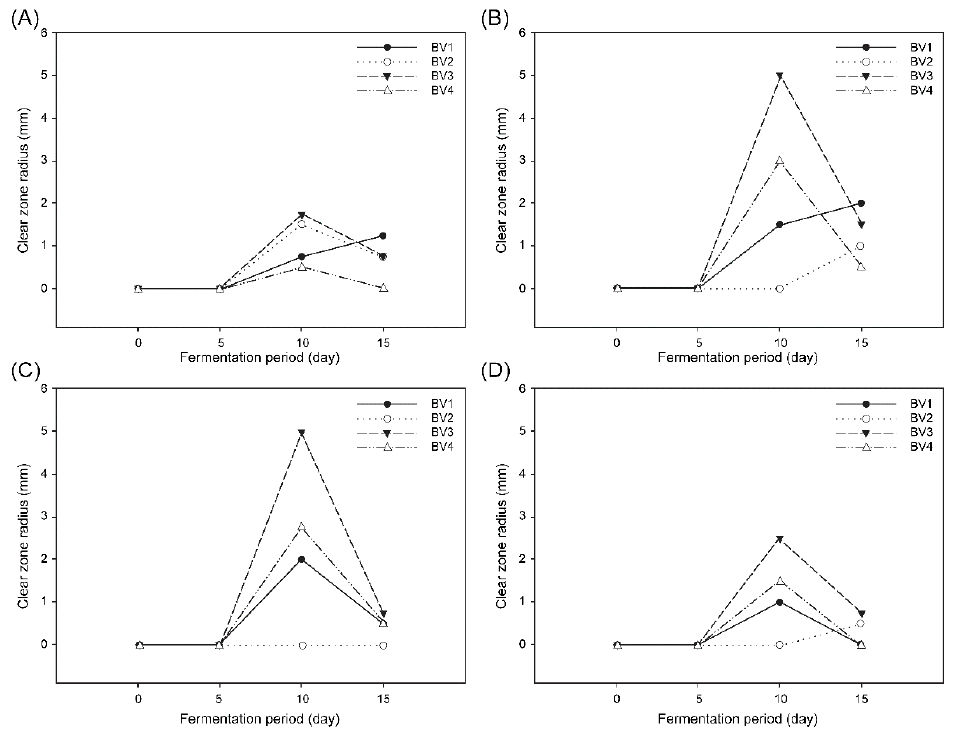
Figure 3. Inhibitory effect of bellflower root vinegar on bacterial strains. ( A ) Bacillus cereus , ( B ) Staphylococcus aureus , ( C ) Escherichia coli , and ( D ) Salmonella Typhimurium. BV1, vinegar from unpeeled bellflower root; BV2, vinegar from peeled bellflower root; BV3, vinegar from unpeeled bellflower root using Acetobacter pasteurianus A11-2; BV4, vinegar from peeled bellflower root using Acetobacter pasteurianus A11-2.